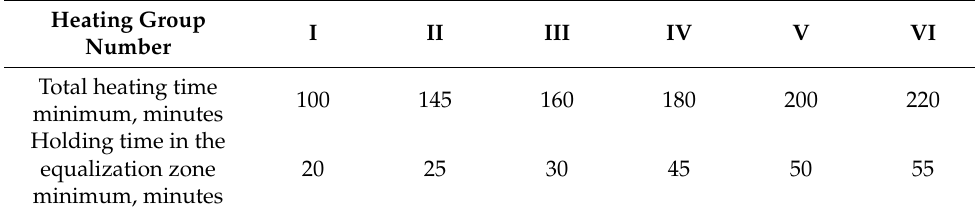
Figure 9. Thermograms of hot ingots. Source: own study based on [61]. Table 5. Ingot heating zones in walking beam furnace.